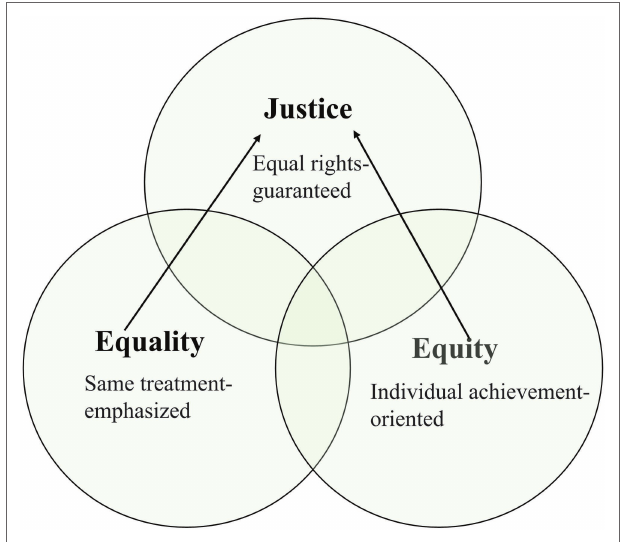
FIGURE 1 | Boolean diagram of the overlapping